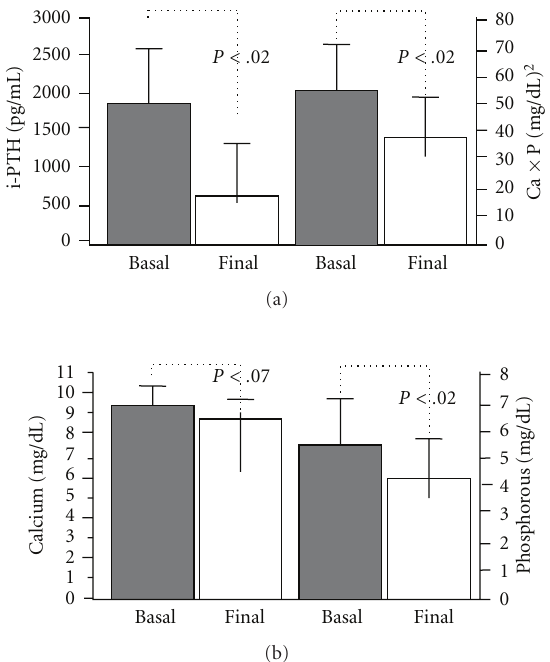
Figure 1: Intact parathyroid hormone, calcium, phosphate, and calcium × phosphorous product levels pre- and post-PEIT.